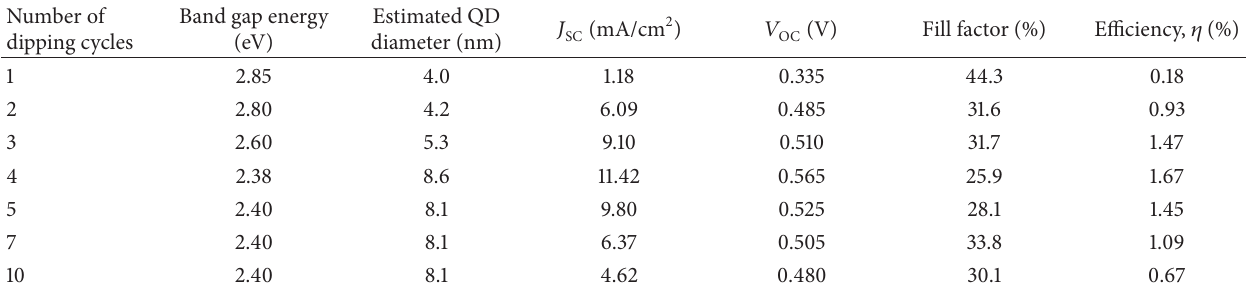
Table 3: The energy gap and size of QDs and QDSSC performance parameters for CdS QDs prepared from various SILAR cycles. Number of dipping